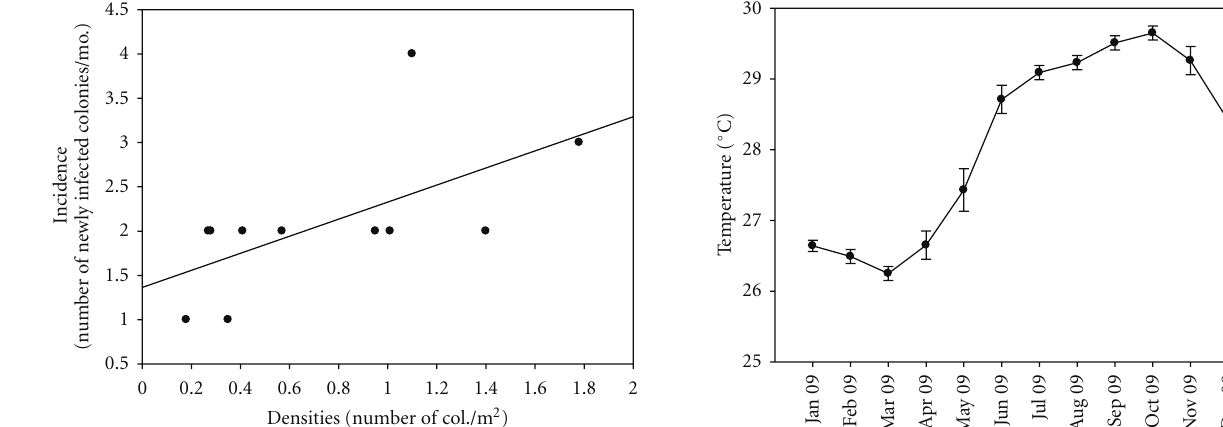
Proportion of monthly CYBD incidence in M. faveo- lata was higher on mid-shelf reefs (0.58 newly infected colonies/month) than on inner (0.41 newly infected colonies/month) or on shelf-edge reefs (0.16 newly infected colonies/month) throughout 2009 ( H = 9 . 74; df = 2; P = 0 . 04). There was a significant positive correlation (Spearman correlation analysis; ρ = 0 . 70, P = 0 . 01) between CYBD 100 m 2 quadrants per site (Figure 3).